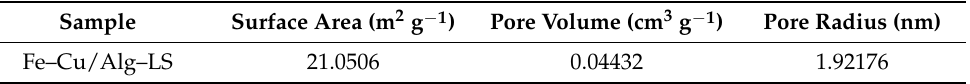
Table 2. The pore size distribution adsorption results (surface area, pore volume and average pore radius).